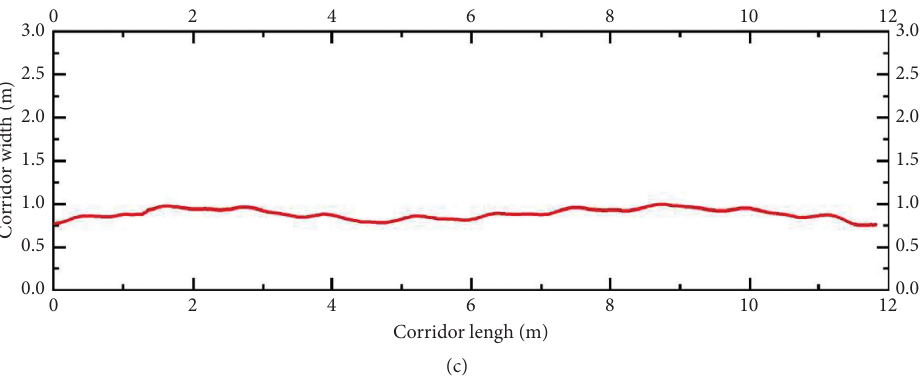
Figure 8: Pedestrian movement trajectories in the image space and real space. (a) Movement trajectory of a typical pedestrian walking in the straight corridor. (b) The movement trajectory is plotted in the image space. (c) The movement trajectory is mapped into the real